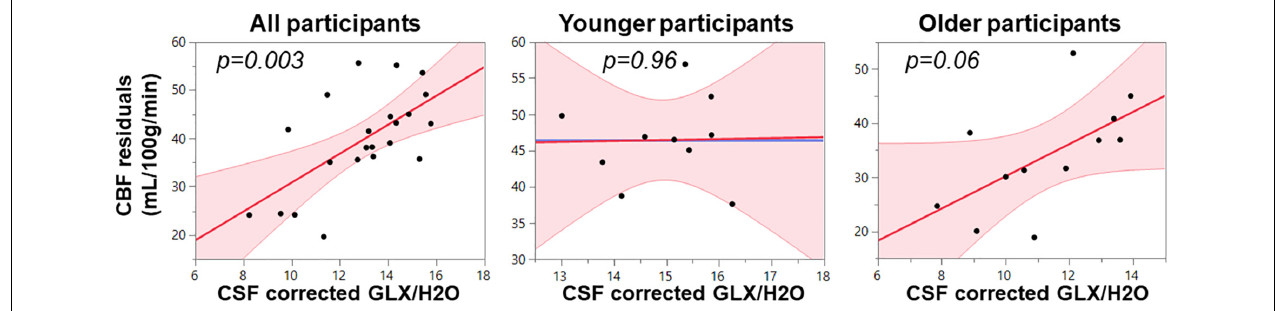
FIGURE 2 | Multimodal regression plots relating CBF to Glx for all, younger, and older participants. Relationships are considered significant at p < 0.05.